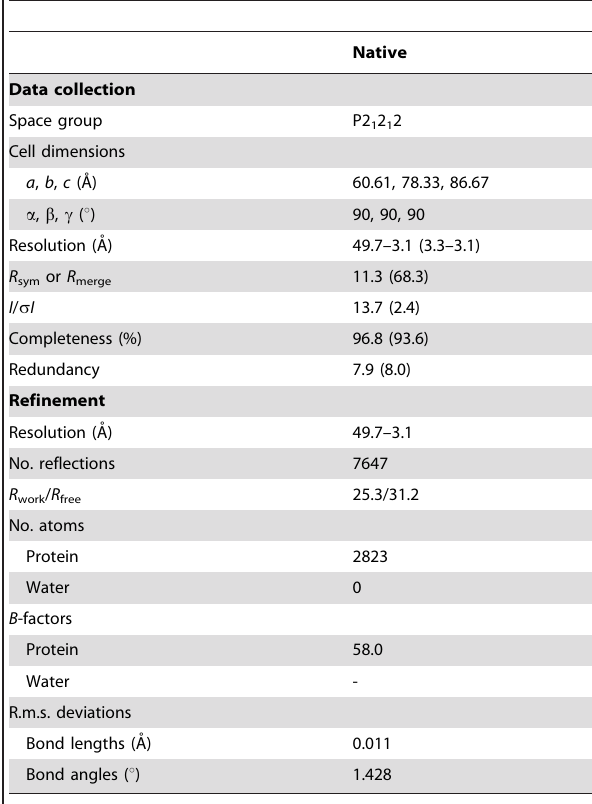
Figure of merit